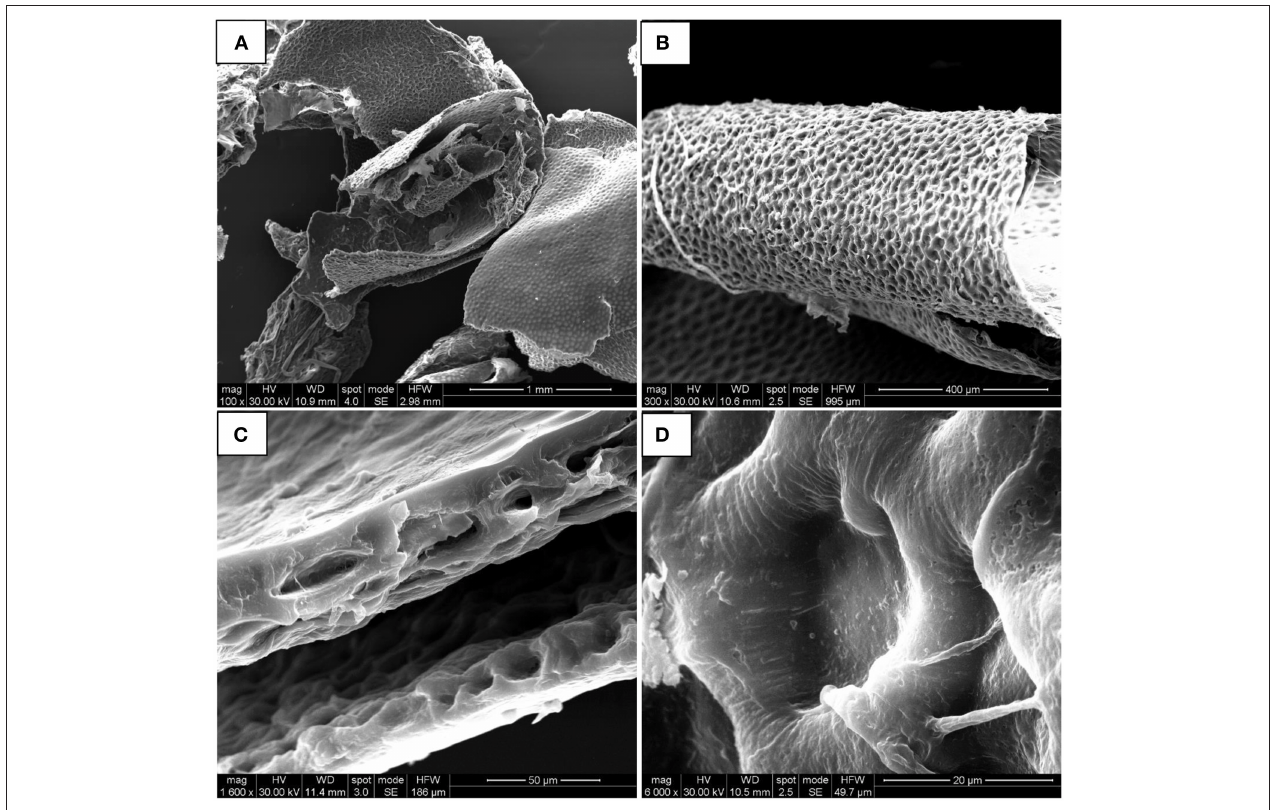
FIGURE 1 | Scanning electron microscopy (SEM) micrographs of tomato peels at 100 × (A) , 300 × (B) , 1,600 × (C) , and 6,000 × (D)